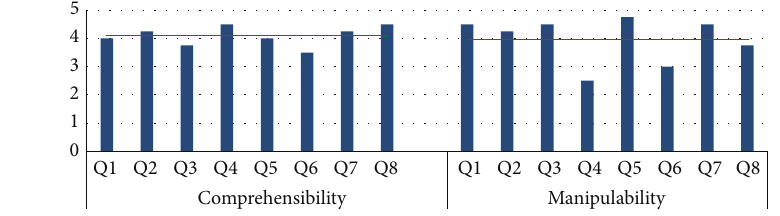
Figure 11: The average score of questions in HARUS questionnaire [49] answered by participants to measure the usability of